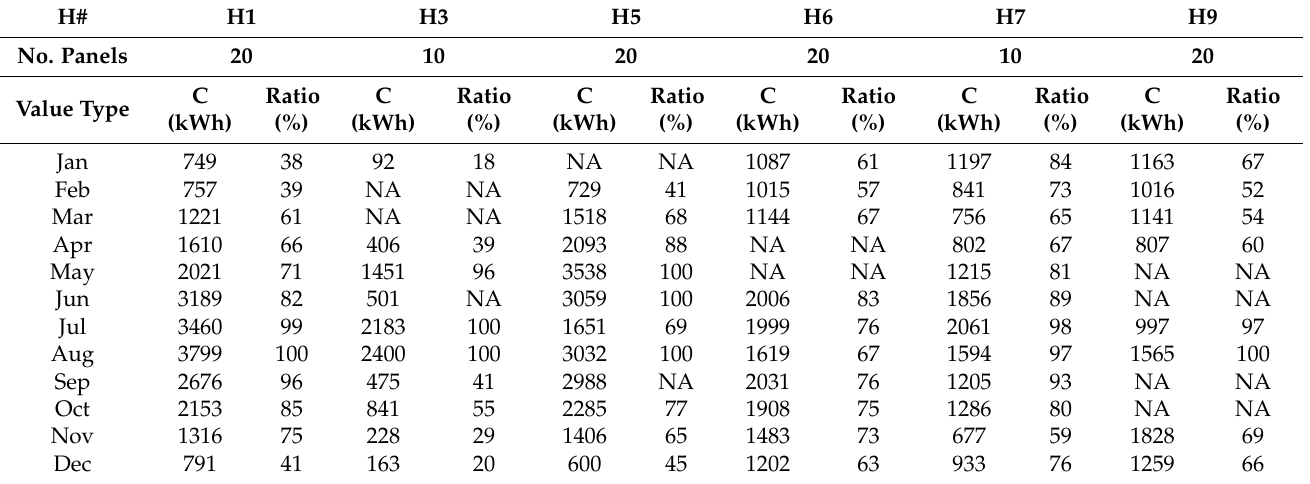
Table 9. Summary of all the self-consumption values (C) in kWh and self-consumption ratios in percentages (%) including houses H1, H3, H5, H6, H7, and H9 for the available monthly